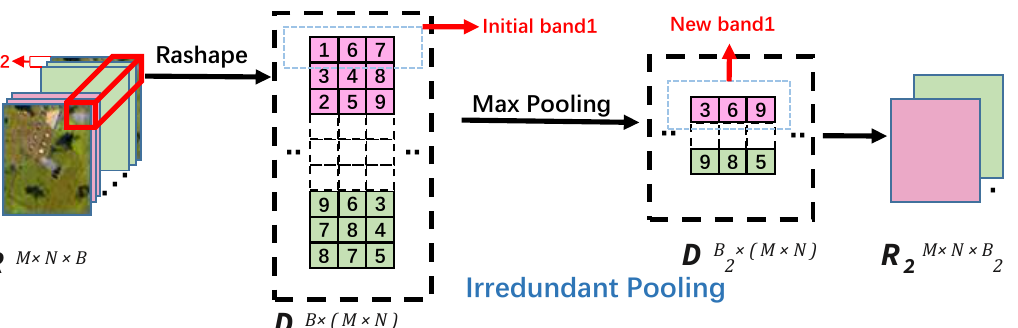
Figure 5. The specific detail of Irredundant